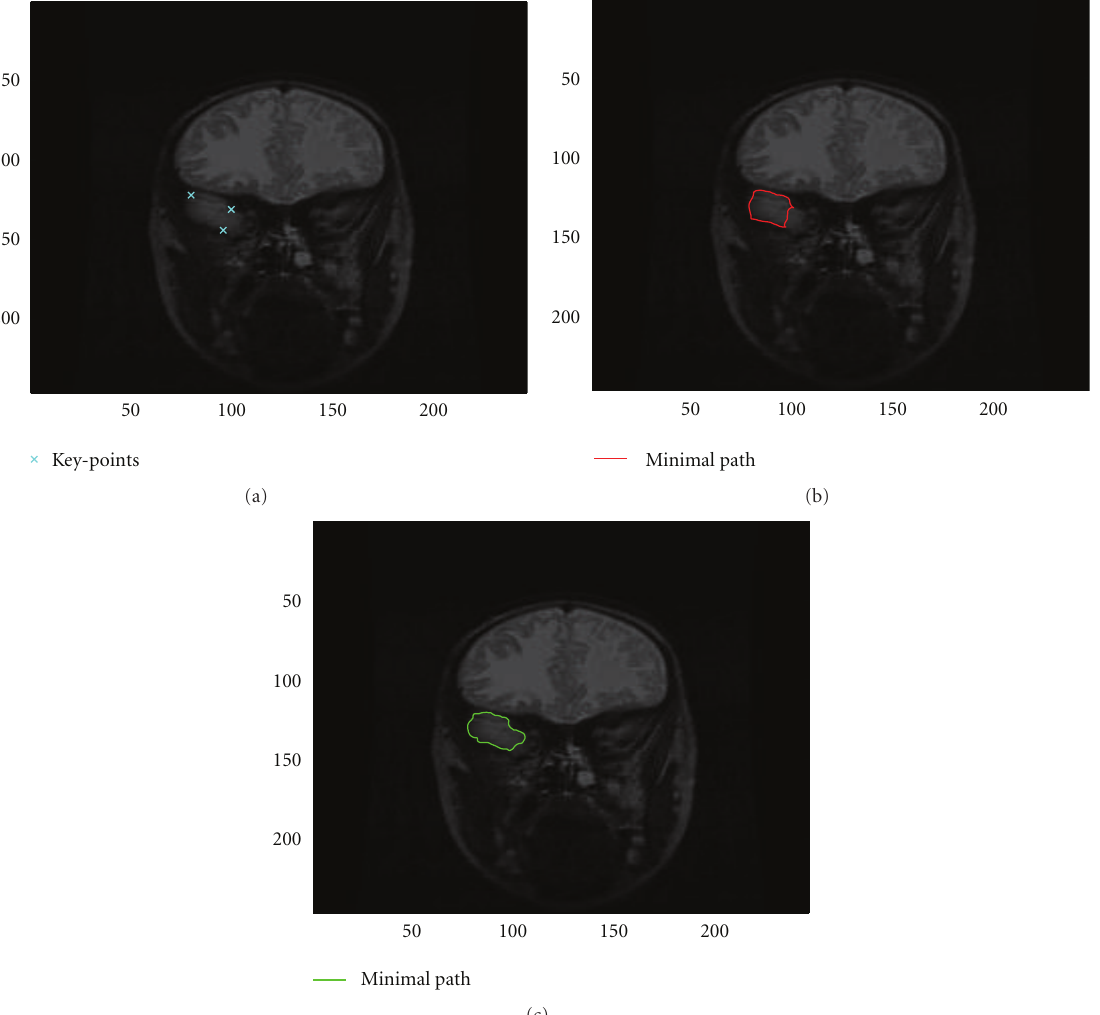
Figure 7: (a) Three selected keypoints on the original image; (b) Contours identified by the fast marching algorithm applied to the standard gradient with the three selected keypoints (see (a)); (c) Contours identified by the fast marching algorithm applied to the topological gradient with the three selected keypoints (see